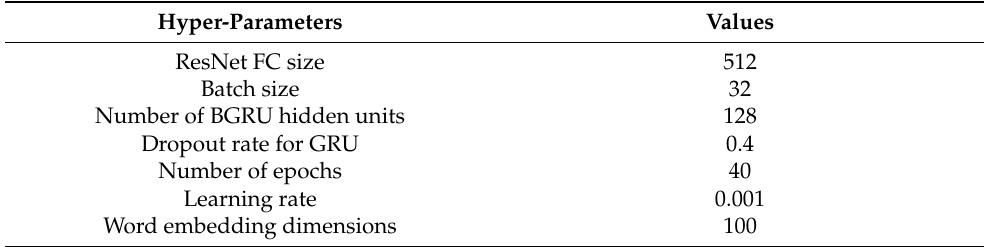
Table 2. The best performing hyper-parameters used for the neural networks were determined by using a grid search